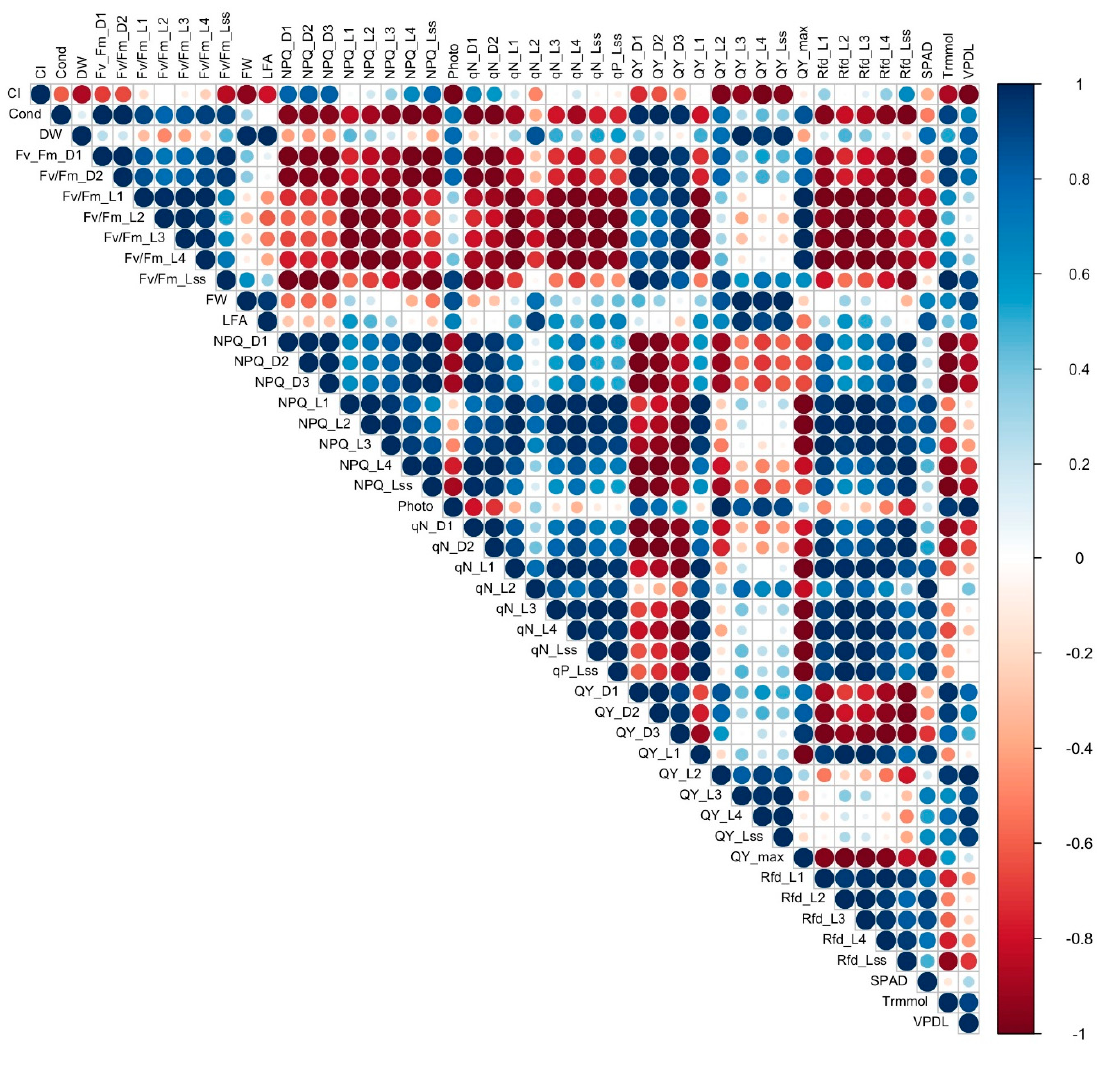
Figure 9. Graphical representation of a correlation matrix of morphological, physiological, and chlorophyll fluorescence parameters between sensitive cultivars “Laura”, “Eruption”, and “Parris Island Cos”, highlighting the most correlated variables. Blue color represents positive correlation whereas red represents negative correlation. Color intensity and size of the circle are proportional to the correlation coefficients which are depicted in the legend to the right.